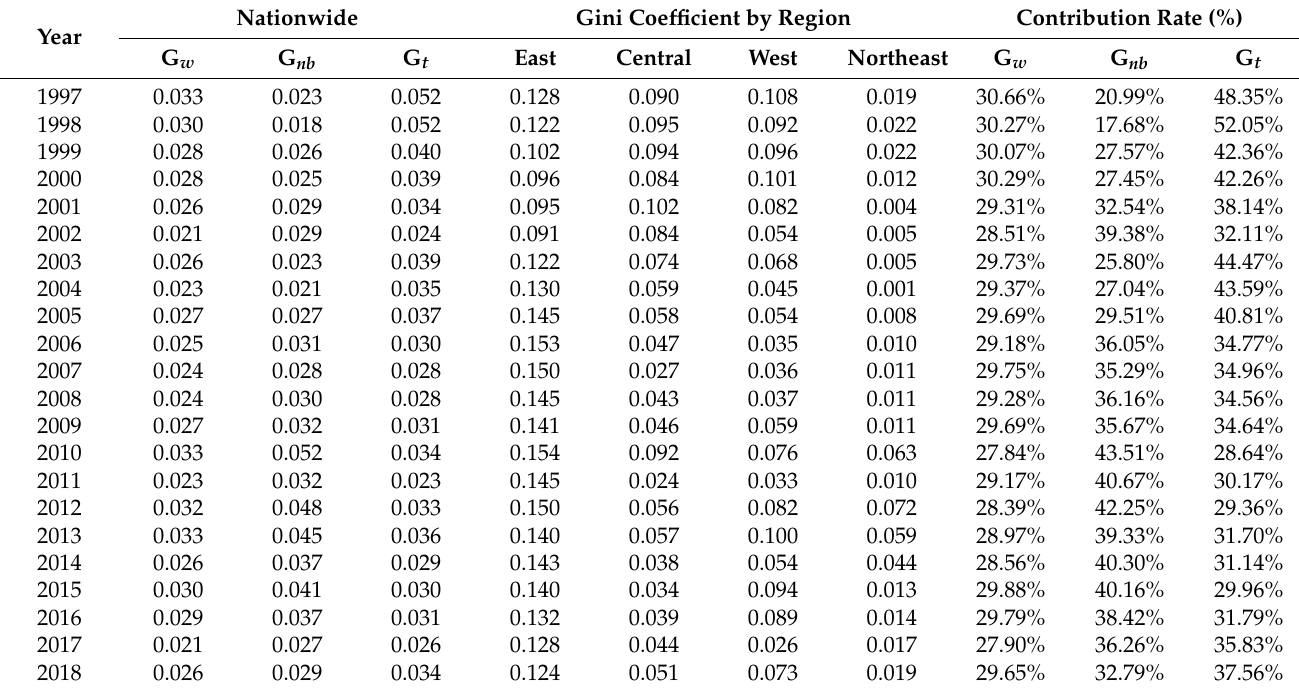
Table 6. Gini coefficients and contribution rates of the four